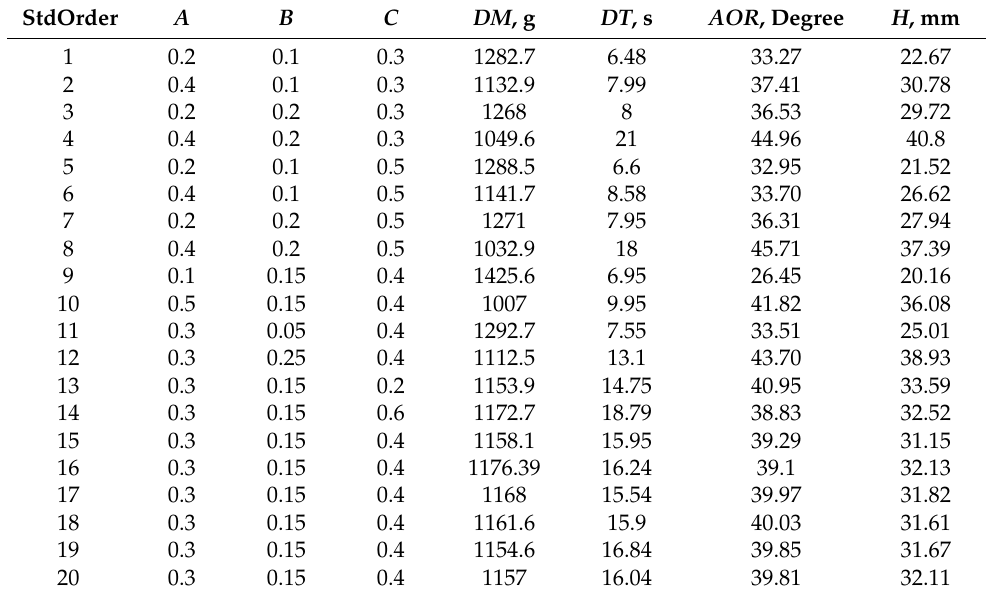
Table 4. EDEM simulation results of the particle-particle interaction properties using the sandglass test.